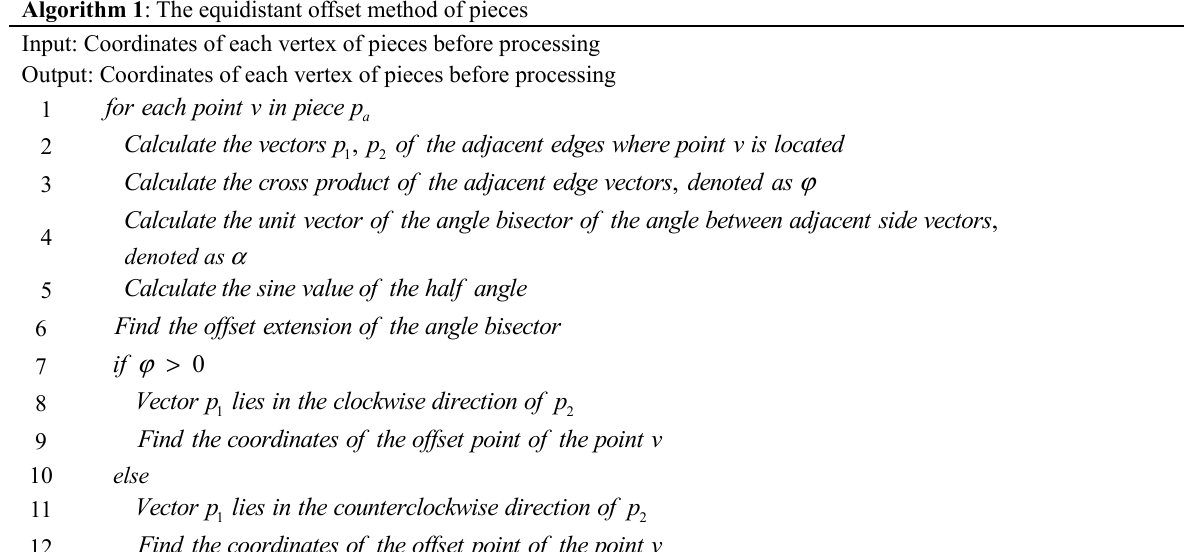
Algorithm 1 : The equidistant offset method of